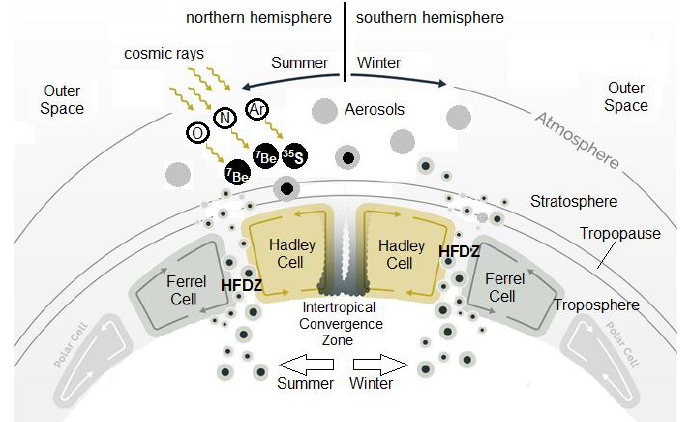
Figure 2. Schematic image displaying the creation of 7 Be and 35 S within the stratosphere by cosmic ray spallation of oxygen/nitrogen and argon, respectively, the attachment of the radionuclides onto aerosol particles and their conveyance towards the earth’s surface via the HFDZ that is shifting in place with the seasons as indicated by the arrows (figure based on [32]).